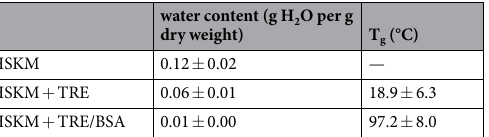
Table 1. Sample moisture contents and T g values of dried samples, as determined directly after freeze-drying. Cells were suspended in saline medium (HSKM) without protective agents, as well as supplemented with trehalose (250 mM) or trehalose/albumin (1/1 mass ratio, 9.5% each); and subjected to freeze-drying as described in detail in the methods section. Water contents were determined gravimetrically, and glass transition temperatures were determined using DSC. Mean values ± standard deviations were determined from four independent experiments.